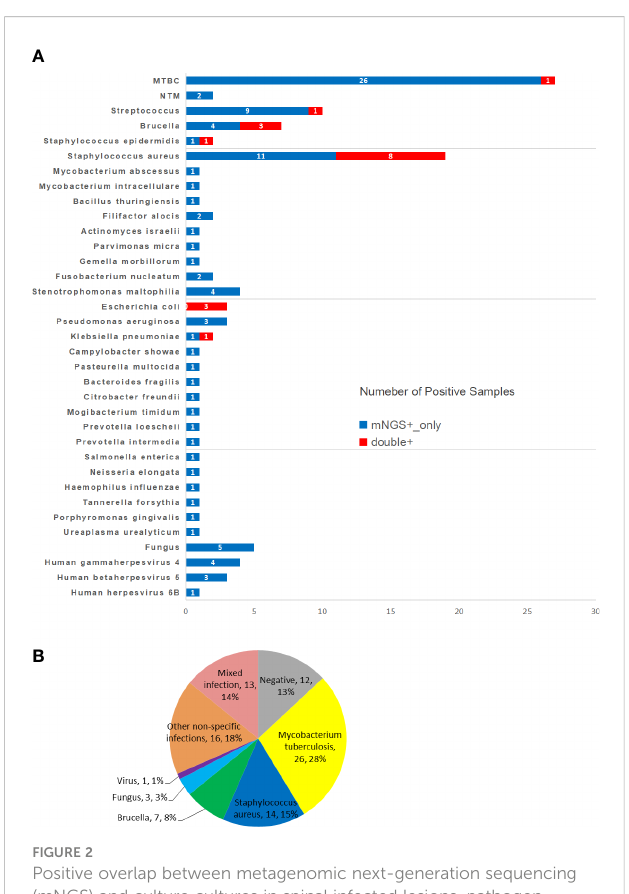
FIGURE 2 Positive overlap between metagenomic next-generation sequencing (mNGS) and culture cultures in spinal infected lesions, pathogen species and frequencies detected by both methods are plotted in histogram (A) . (B) Pie chart shows the classi fi cation of mNGS detection results for 92 spinal infection patient samples. mNGS, metagenomic next-generation sequencing; MTBC, Mycobacterium Tuberculosis Complex ; NTM, nontuberculous